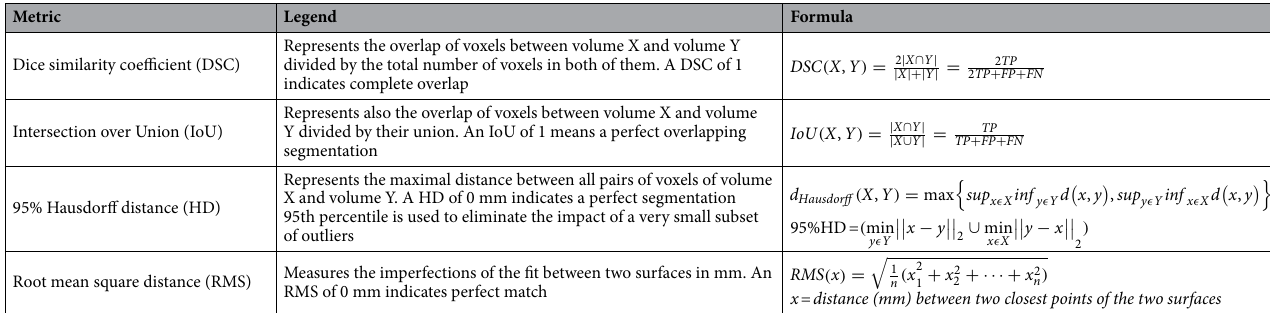
Table 2. Metrics used for assessing accuracy and